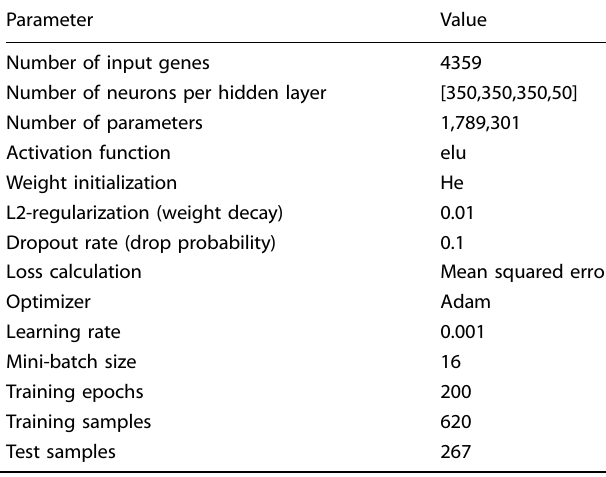
Table 2. Fully connected neural network parameters.